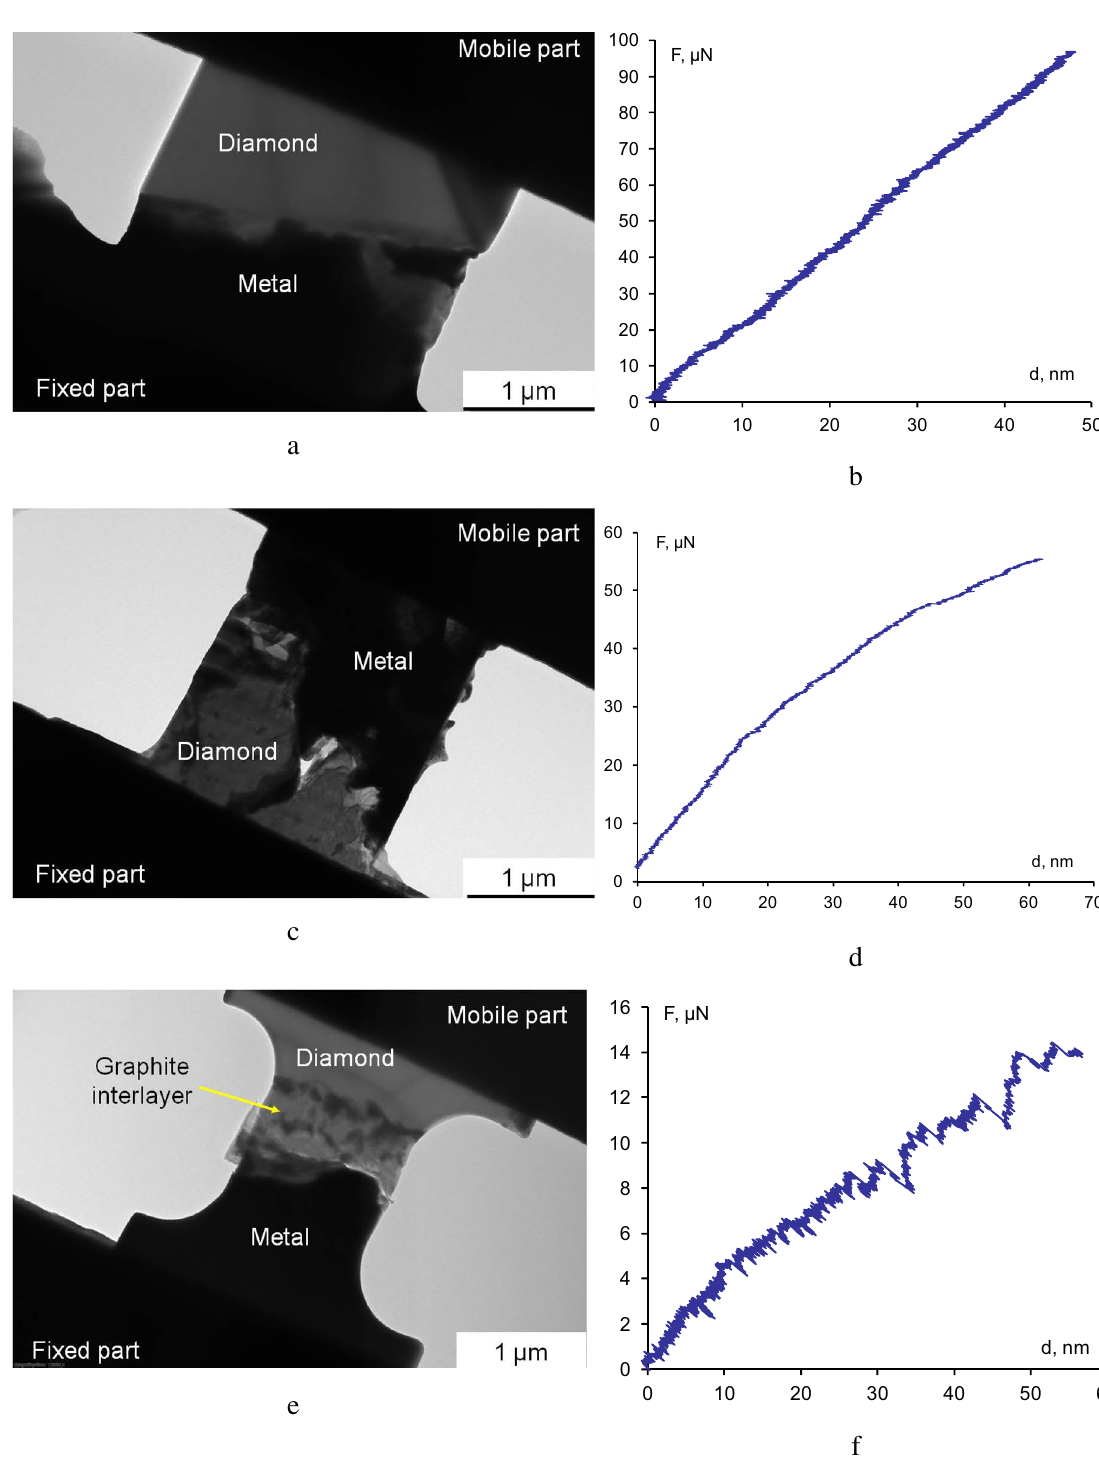
Figure 4. TEM images of Lamellae 1–3 before the tests ( a , c , e ) and the diagrams showing the applied load vs. indenter displacement during the tests ( b , d , f